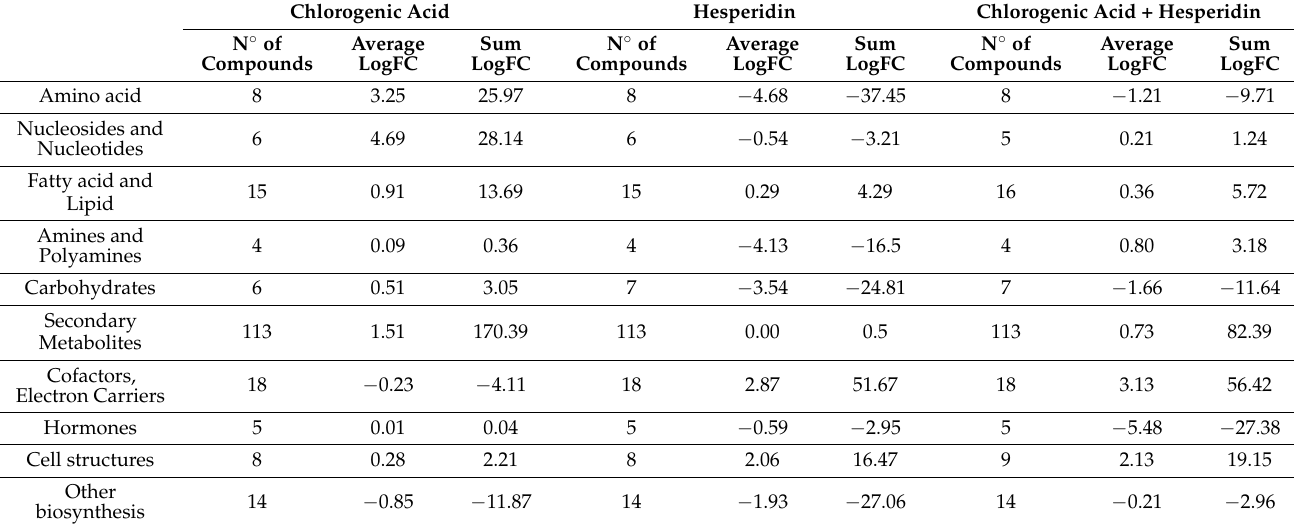
Table 1. Summary of different pathways activated in lettuce treated with 100 µ M hesperidin, 50 µ M chlorogenic acid, 100 µ M HES + 50 µ M CA. For each pathway highlighted under the different treatments, the number of compounds involved, average Log fold-change value (LogFC), and sum LogFC are provided. The LogFC values refer to a pairwise comparison between each treatment vs. control